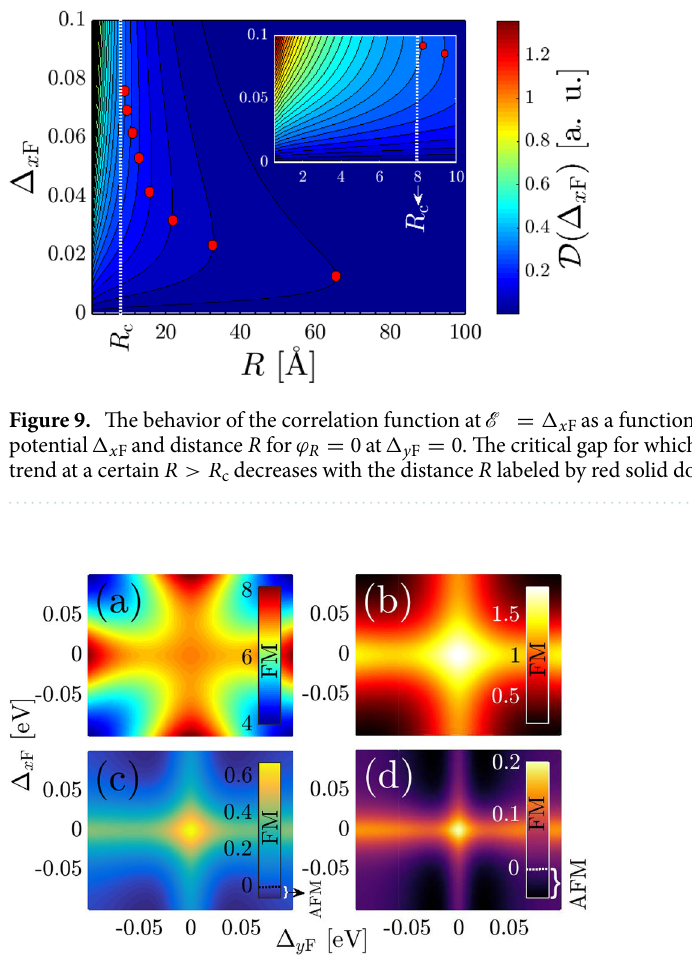
4 at ϕ 0 , to the 10 R = − × 10 Å, ( b ) R 30 Å, ( c ) R 50 Å, = = =